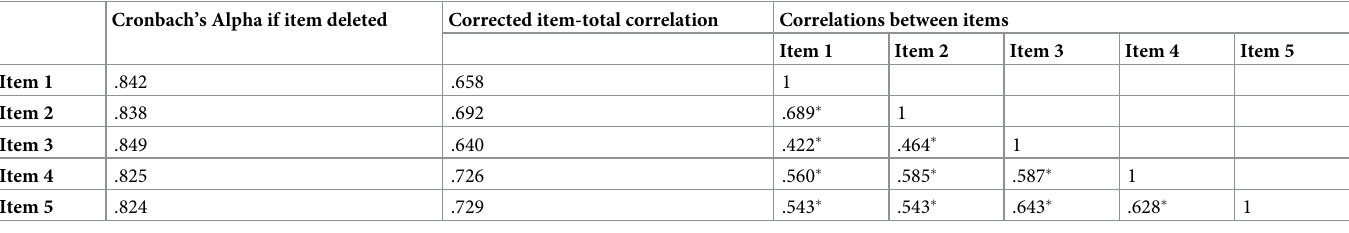
Table 4. Cronbach’s alpha if item is deleted, corrected item-total score correlation, and correlations between items. Cronbach’s Alpha if item